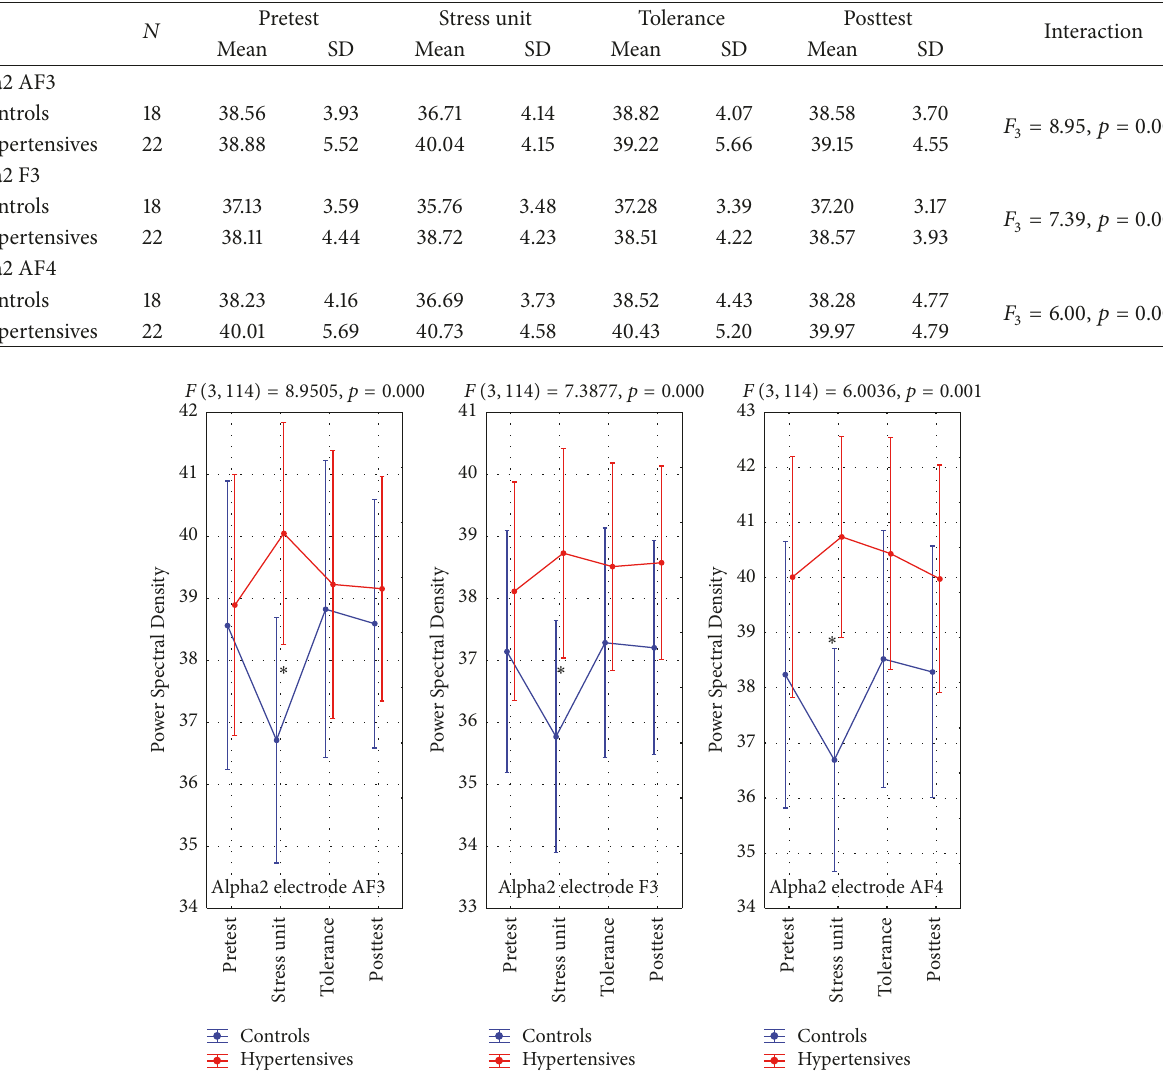
Figure 4: Alpha2 brain activity (A2BA). ∗ refers to statistically significant